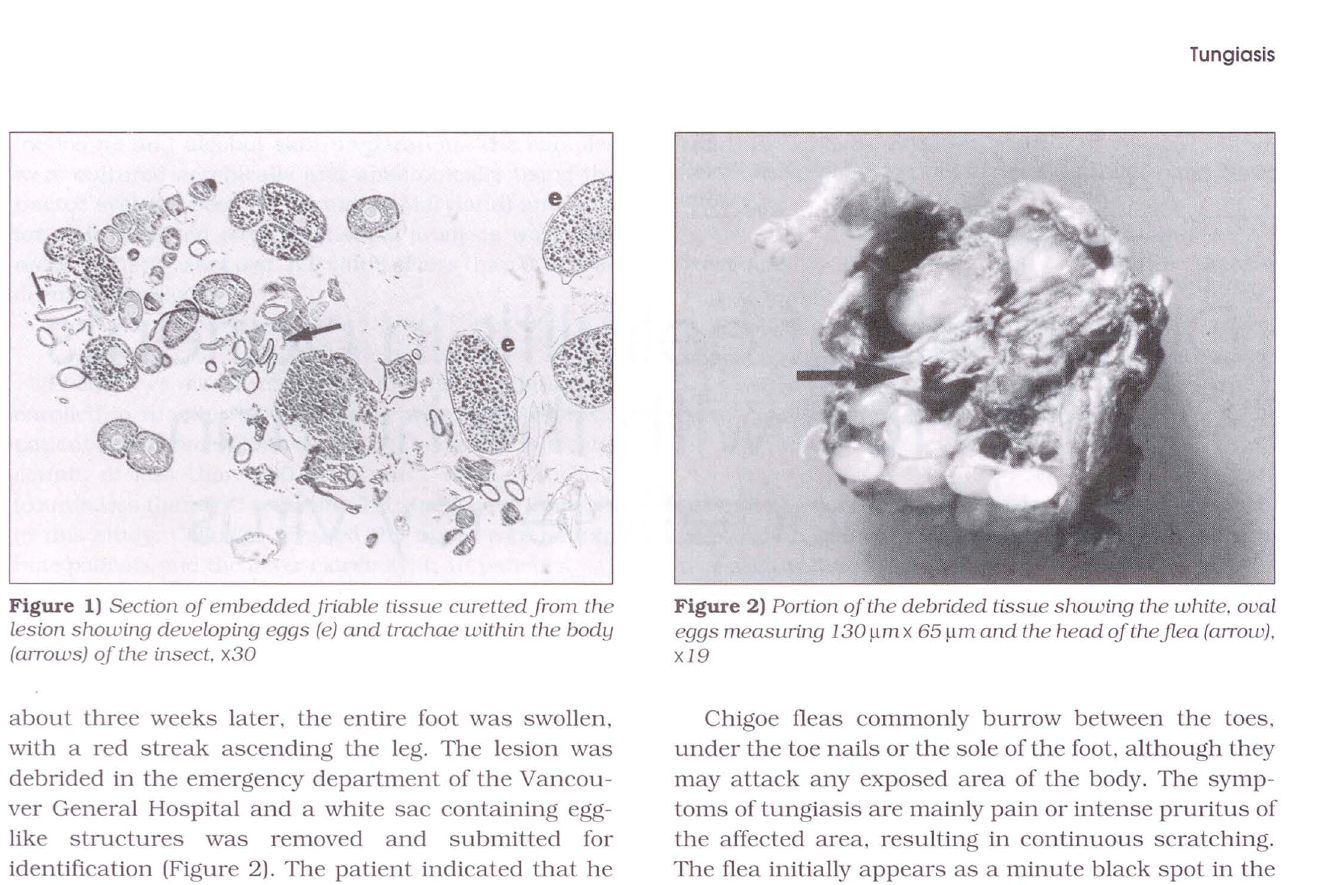
Figure 1) Section of embeddedjhable tissue curettedji-om the lesion showing developing eggs (e) and trachae within the body (arrows) of the insect. x30